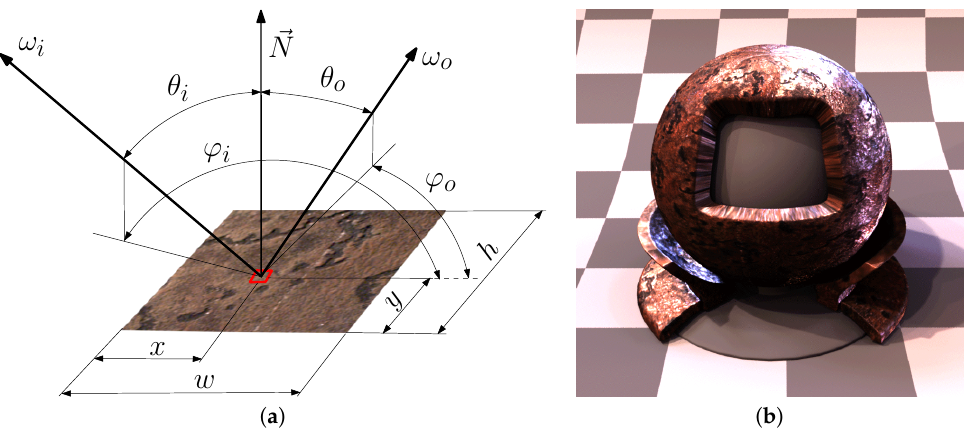
Figure 2. ( a ) A BTF parameterization corresponding to the ideal measurement arrangement of a planar sample of width w and height h of a texel at coordinates x , y . The illumination is provided by collimated incident light in the direction ω i = ( θ i , ϕ i ) over the whole measured sample. (cid:126) N is the normal over the whole plane with the measured sample, ω o = ( θ o , ϕ o ) is the outgoing light direction; ( b ) rendered image example, showing a 3D object covered with a measured